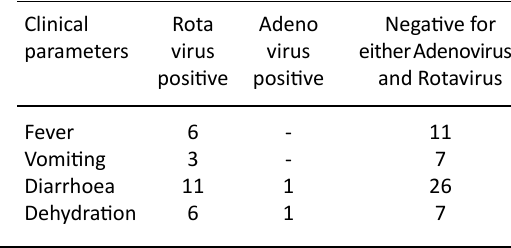
table 1. Number of Rotavirus and Adenovirus cases Test result